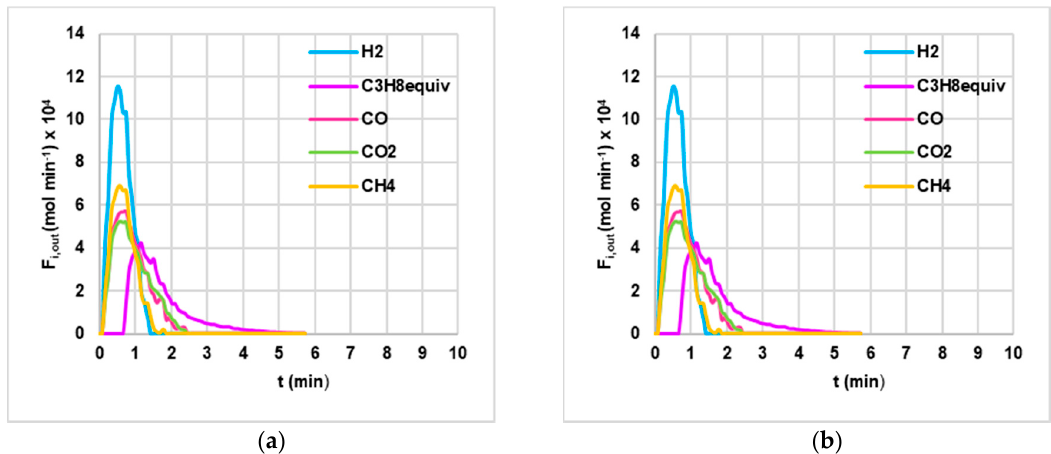
Figure 5. Example of H 2 , CO, CO 2 , CH 4 and equivalent C 3 H 8 outlet molar flow rates ( F i,out ) as functions of time ( t ) produced by devolatilizations of AHPam ( a ) and AHPus ( b ), in the sand fluidized bed, at 800 °C, under nitrogen plus air atmosphere (diluted air).